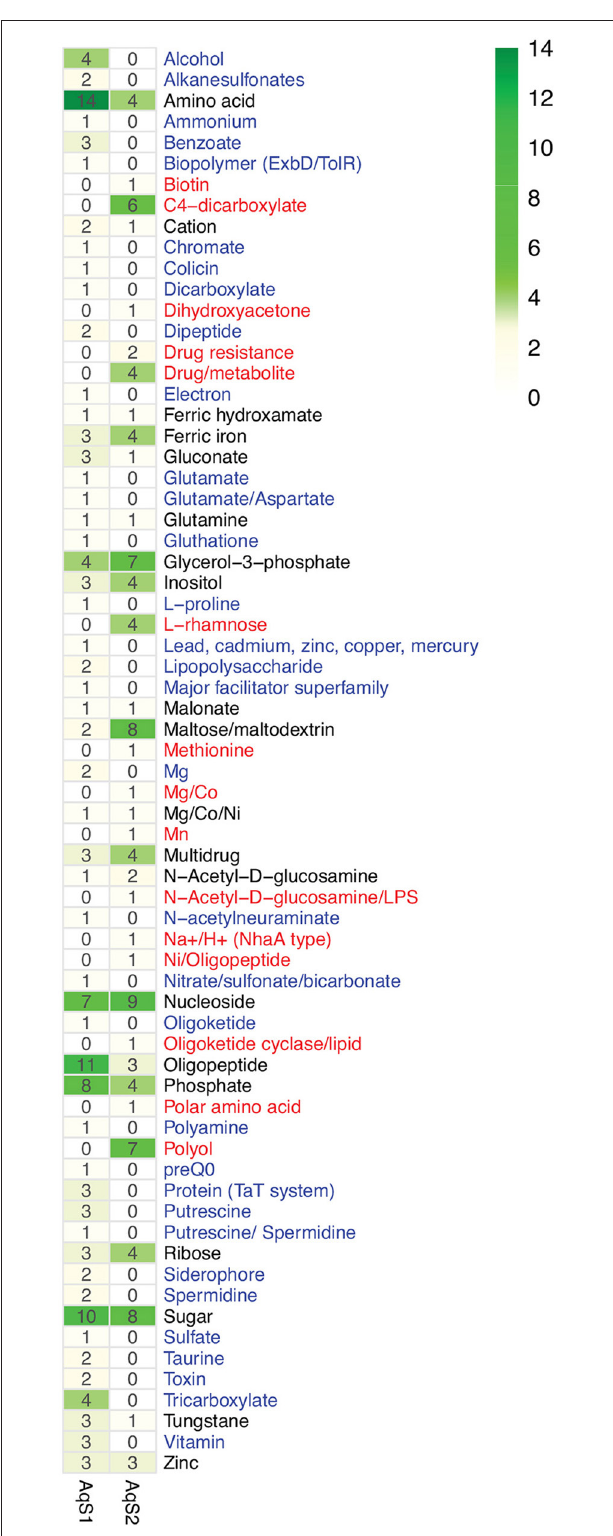
FIGURE 6 | Counts of putative substrates derived from predicted transporters present in the genome of AqS1 only (blue), AqS2 only (red), or both